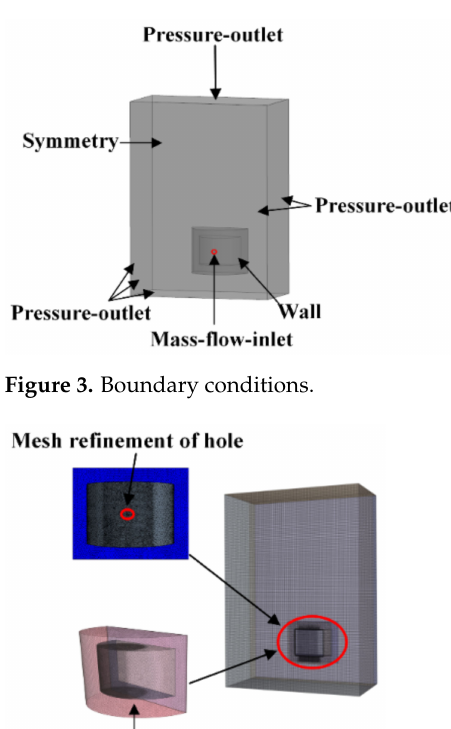
Figure 2. Process flow chart of overset mesh.